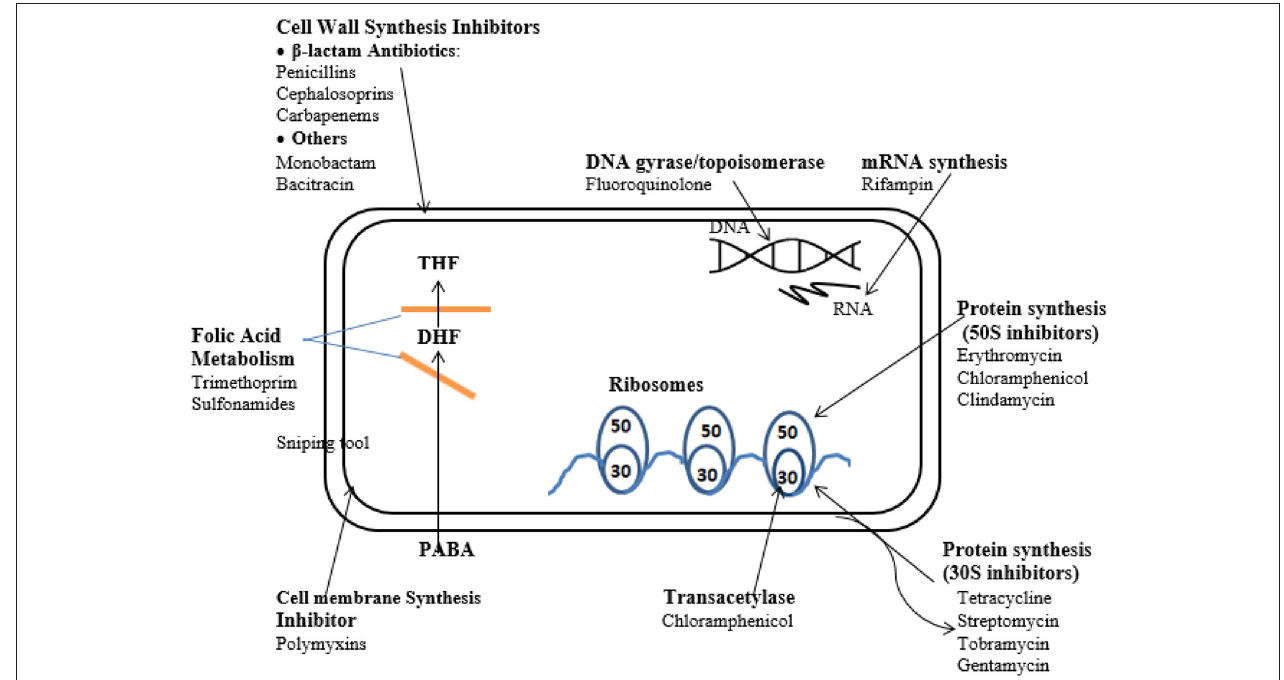
FIGURE 2 | Mode of action of antimicrobial